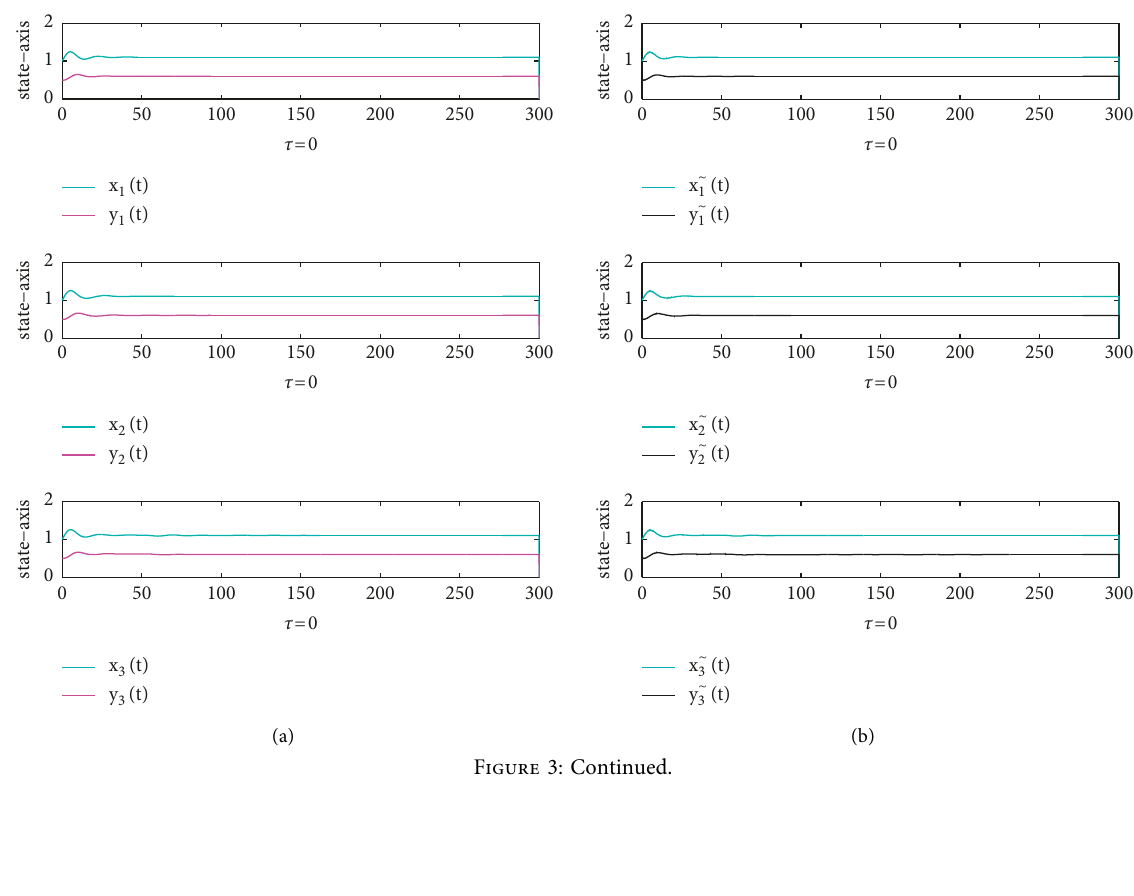
( x ∗ , y ∗ ) of the deterministic system (2) and the stochastic system (21) with f i i i ( t ) and x ∼ ( t ) , i � 1 , 2 , 3 represent the intensities of prey species, and y i i � 3